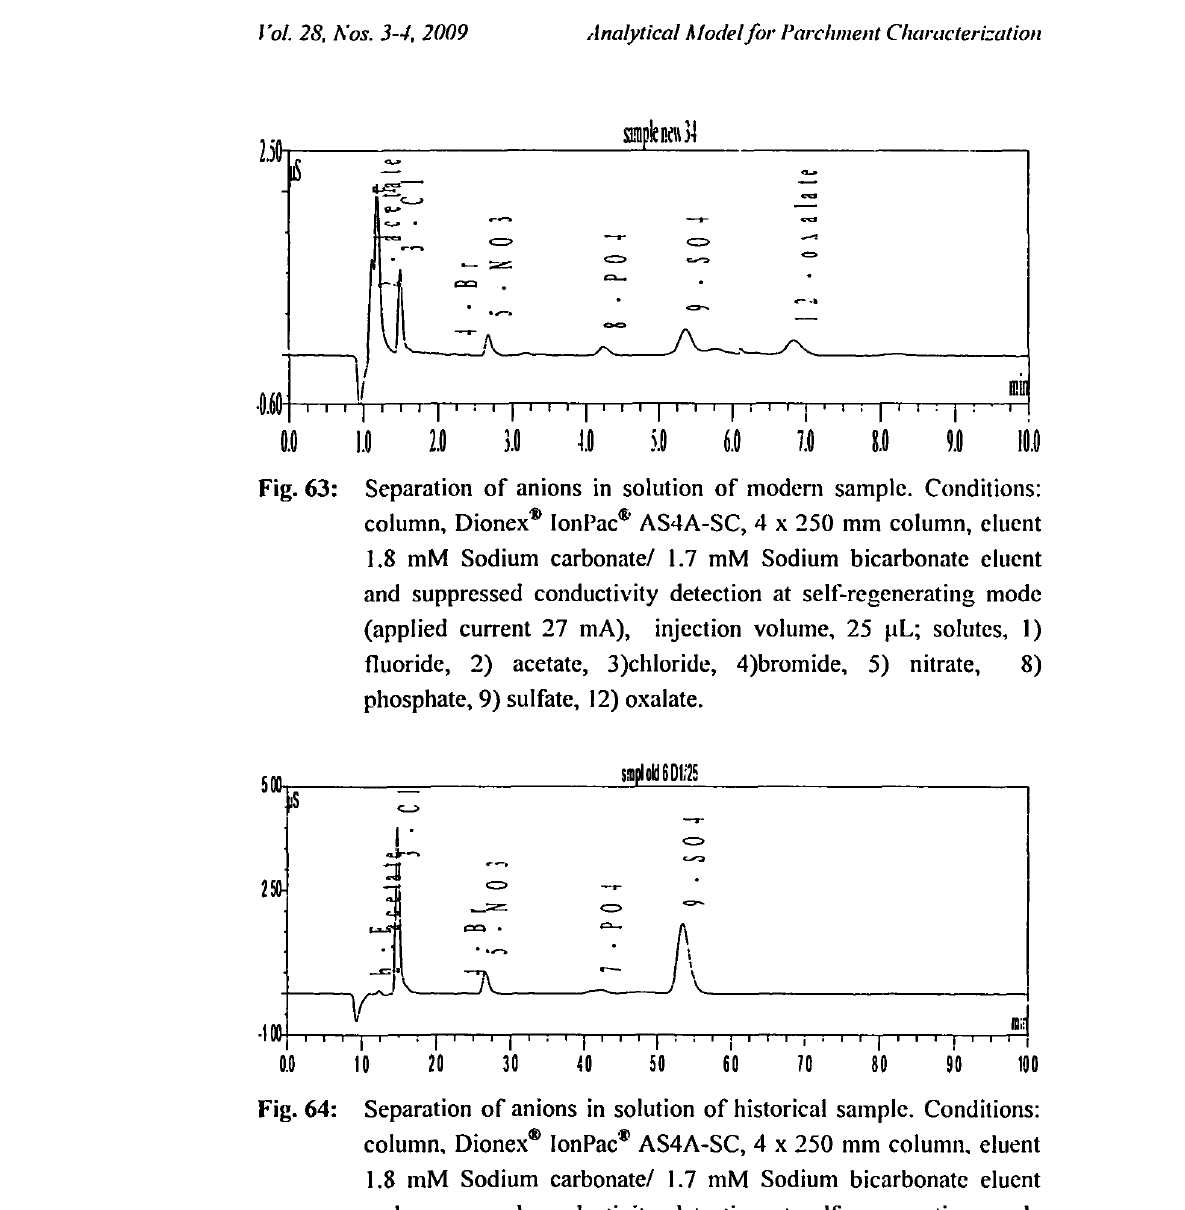
Fig. 64: Separation of anions in solution of historical sample. Conditions: column, Dionex® lonPac* AS4A-SC, 4 χ 250 mm column, eluent 1.8 mM Sodium carbonate/ 1.7 mM Sodium bicarbonate eluent and suppressed conductivity detection at self-regenerating mode (applied current 27 mA), injection volume, 25 \iL: solutes, I) fluoride, 2) acetate, 3)chloride, 4) bromide, 5) nitrate, 7) phosphate, 9) sulfate.